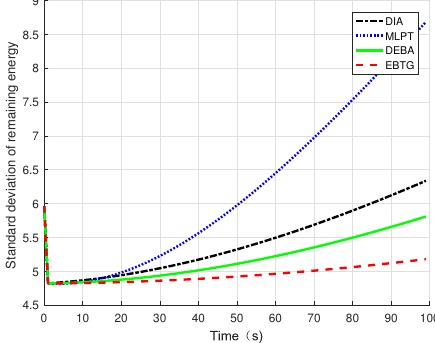
Figure 8. Standard deviation of node residual energy.